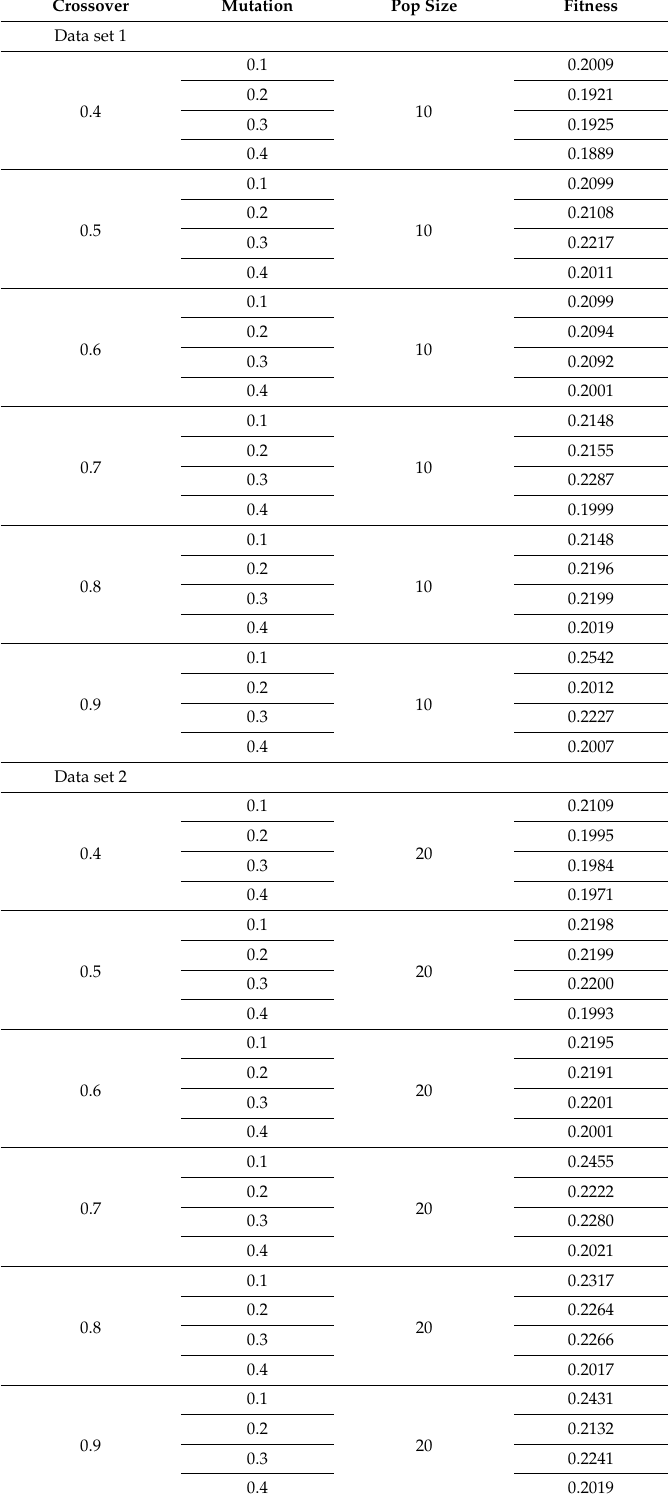
Table 1. Effect of crossover, mutation rate, and population size on objective function in genetic algorithms (GA) by sensitivity